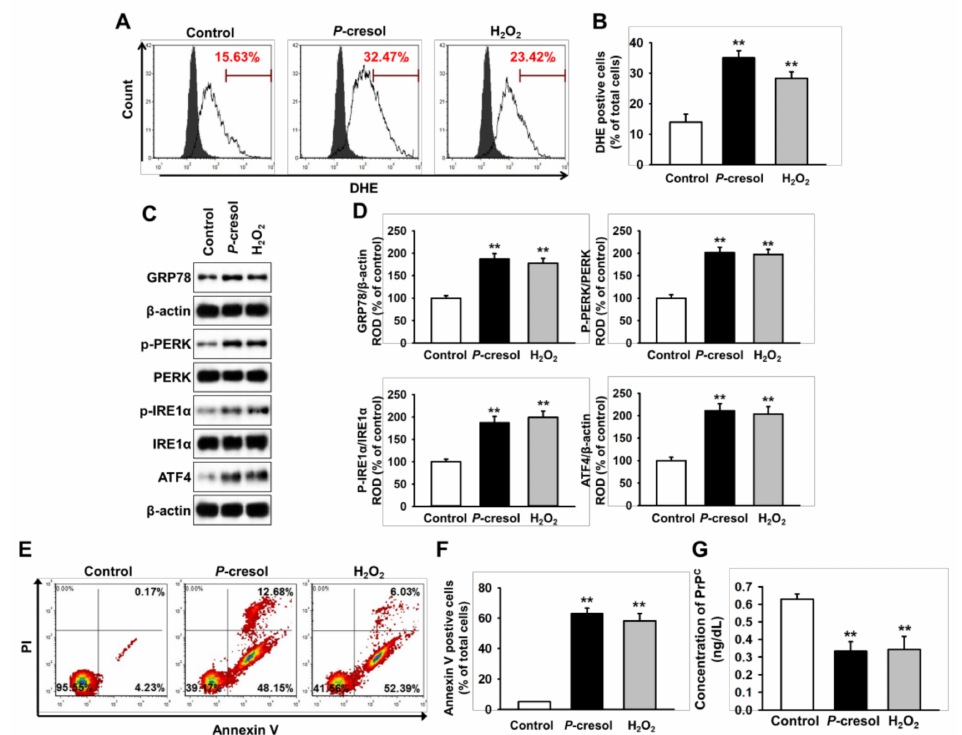
Figure 1. Uremic toxin-induced apoptosis in SH-SY5Y cells through induction of reactive oxygen species (ROS)-mediated endoplasmic reticulum (ER) stress. ( A ) Flow cytometry analysis for dihydroethidium (DHE) in SH-SY5Y cells after treatment with P -cresol (500 µ M) for 48 h and H 2 O 2 (200 µ M) for 4 h ( n = 5). The filled and clear histograms represent the cells in the absence and presence of DHE, respectively. ( B ) Quantification of the percentage of DHE positive cells. ( C ) Western blot analysis for GRP78, phosphorylation of protein kinase R (PKR)-like endoplasmic reticulum kinase (p-PERK), PERK, phosphorylation of inositol-requiring enzyme 1 α (p-IRE1 α ), IRE1 α , and activating transcription factor 4 (ATF4) in SH-SY5Y cells after treatment with P -cresol and H 2 O 2 ( n = 3). ( D ) The protein levels of ( C ) were determined by densitometry relative to β -actin. ( E ) Flow cytometry analysis for PI/Annexin staining in SH-SY5Y cells after treatment with P -cresol and H 2 O 2 ( n = 5). ( F ) Quantification of the percentage of Annexin V positive cells. ( G ) The concentration of PrP C in SH-SY5Y cells after treatment with P -cresol and H 2 O 2 , as assessed by ELISA (n = 5). Statistical analysis: Values represent the mean ± standard error of the mean (SEM). ( B ) ** p < 0.01 vs. control. ( D ) ** p < 0.01 vs. control. ( F ) ** p < 0.01 vs.